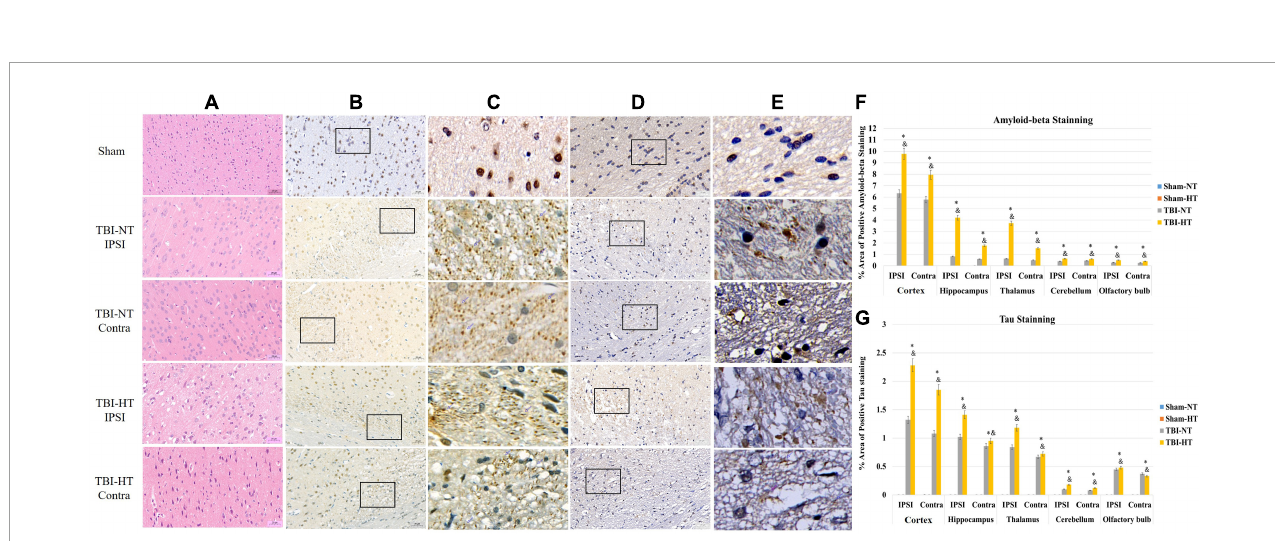
FIGURE7 Representative pathological and immunostaining photomicrographs of cortex from sham, TBI-NT-IPSI, TBI-NT-Contra, TBI-HT-IPSI, TBI-HT-Contra. Sections are labeled with (A) H&E, (B,C) P-tau, and (D,E) β -amyloid deposition. P-tau (B,C) and β -amyloid (D,E) expression in the TBI-HT group was stronger than in the TBI-NT and sham control groups. Moreover, P-tau (B,C) and β -amyloid (D,E) expression in the ipsilateral cortex of TBI-NT or TBI-HT injury was stronger than in the contralateral cortex of TBI-NT or TBI-HT injury. Contra is the contralateral hemisphere of the damage; IPSI is the ipsilateral hemisphere of the injury. Scale bar 20 µ m. (C) Moreover, (E) was enlarged from the solid boxes from panels (B,D) , respectively. Quantification of bilateral, subregional p-tau and A β immunoactivity across groups is shown in panels (F,G) , respectively. The density of subregional p-tau and β -amyloid protein immunostaining is expressed as a percentage of the subregional area. Significantly increased P-tau and β -amyloid protein, determined by mean positive area, were identified in all subregional brains in TBI-HT, compared with TBI-NT, and in TBI, compared with sham. ∗ p < 0.05 vs. sham group; & p < 0.05 vs. TBI-NT group. Data in panels (F,G) : Sham-NT n = 4, Sham-HT n = 4, TBI-NT n = 6, TBI-HT n = 6, pooled data from four independent experiments. All n values refer to the number of rats used, and the error bars depict the mean ± SD. One-way ANOVA was used to calculate p -values with Bonferroni’s multiple comparison test, and p < 0.05 indicated significance. Contra, contralateral hemisphere; IPSI, ipsilateral